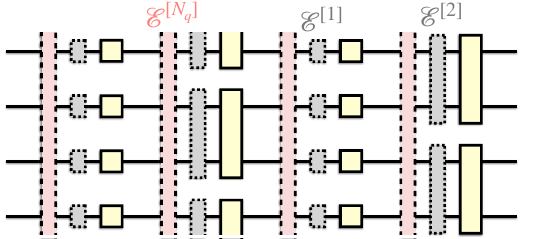
FIG. 5. The test circuit configuration with depth = 4 and N q = 4. We add i -qubit ( i = 1, 2) noise E [ i ] after each ideal i -qubit gate and global N q -qubit depolarizing noise E [ N q ] after each layer.